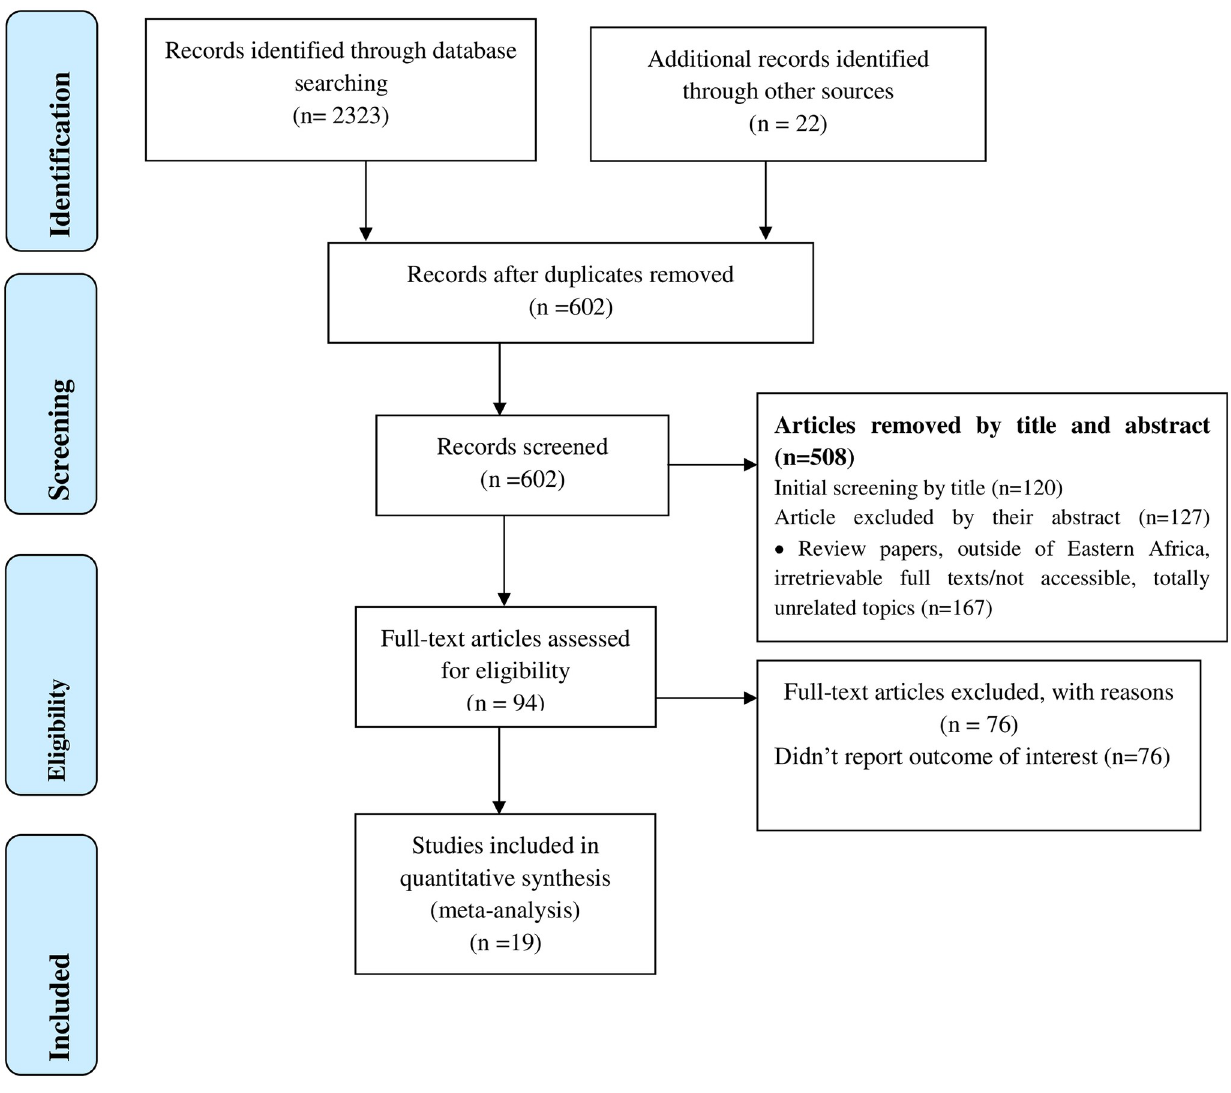
Fig 1. PRISMA–adapted flow diagram showed the results of the search and reasons for exclusion